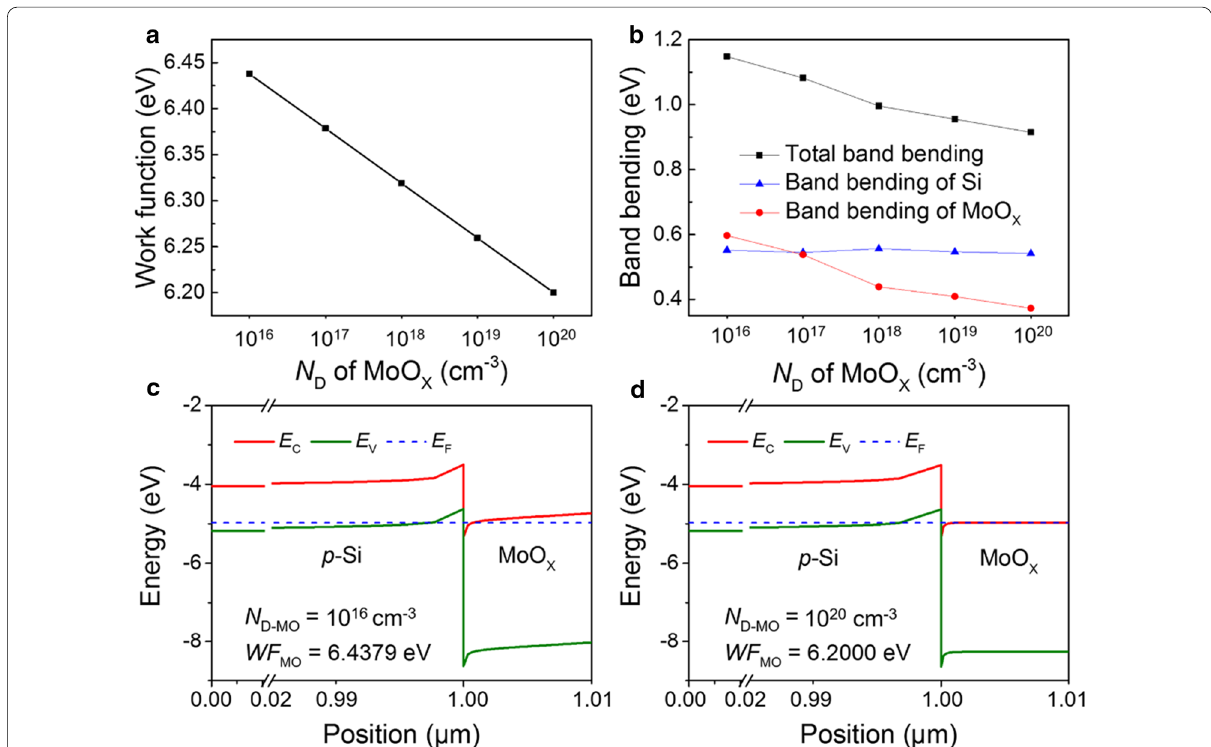
Fig. 5 Simulated energy band results of the p -Si/MoO X contact. a The relationship between the work function and N D of MoO X ( N D-MO ). b The p -Si, MoO X and the total band bending for p -Si/MoO X contact. The acceptor concentration of p -Si is 1 10 16 cm − 3 . Simulated band diagrams of p -Si/ × MoO X contact as the N D-MO is c 1 10 16 cm − 3 and d 1 10 20 cm − 3 , × ×